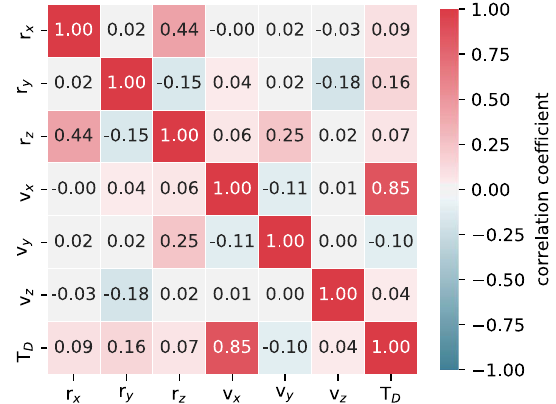
Fig. 8. Correlation matrix of the machine learning features (position of ACE ( r x , r y , r z ), solar wind speed ( v x , v y , v z )) and the measured solar wind delay T D of the database.